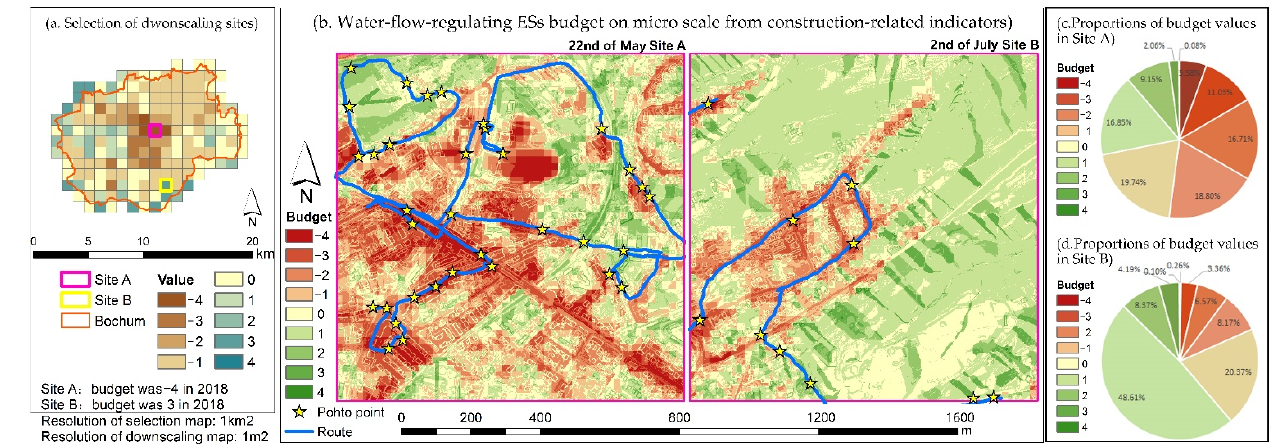
Figure 8. Water-flow-regulating ESs assessment results on downscaling sites. Figure 7. Water-flow-regulating ESs assessment results on downscaling